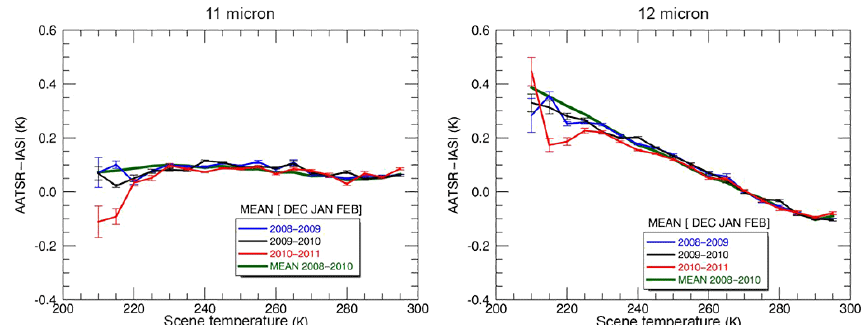
Figure 7. Year to year AATSR–IASI bias for DJF for the 11 and 12µm channels. An anomalous trend at cold temperature is clearly visible in November 2010 DJF.